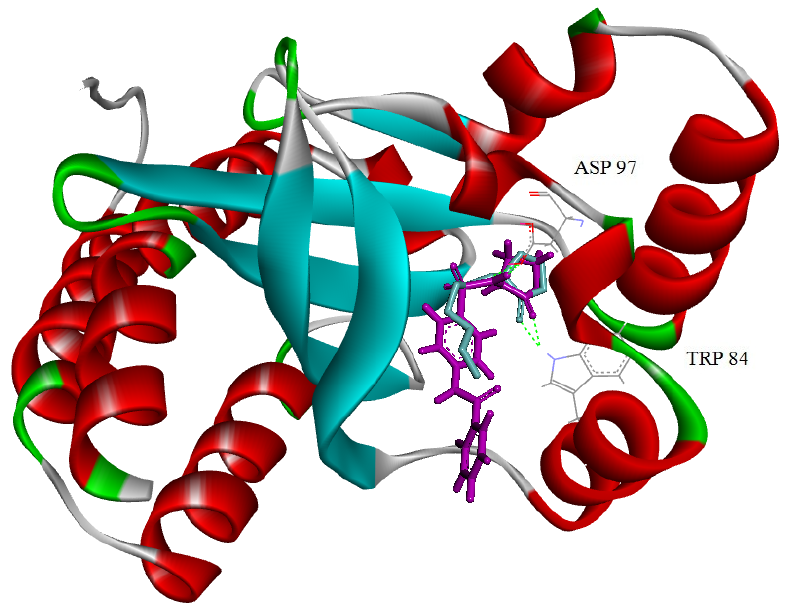
-HSL and compound 5h bound to the active 6